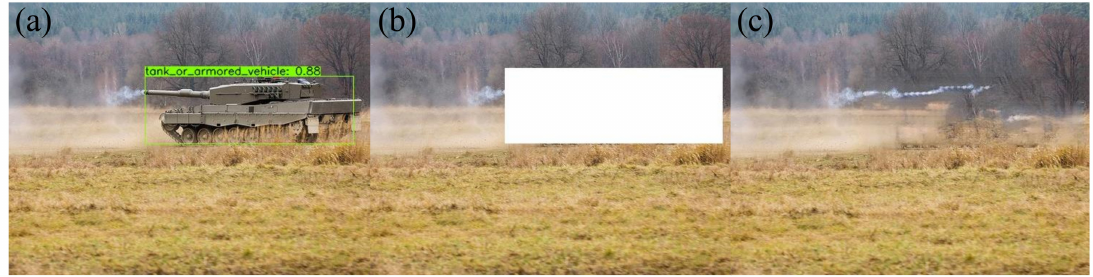
Figure 9. Preliminary camouflage texture design. ( a ) original image; ( b ) masked image; ( c ) completed